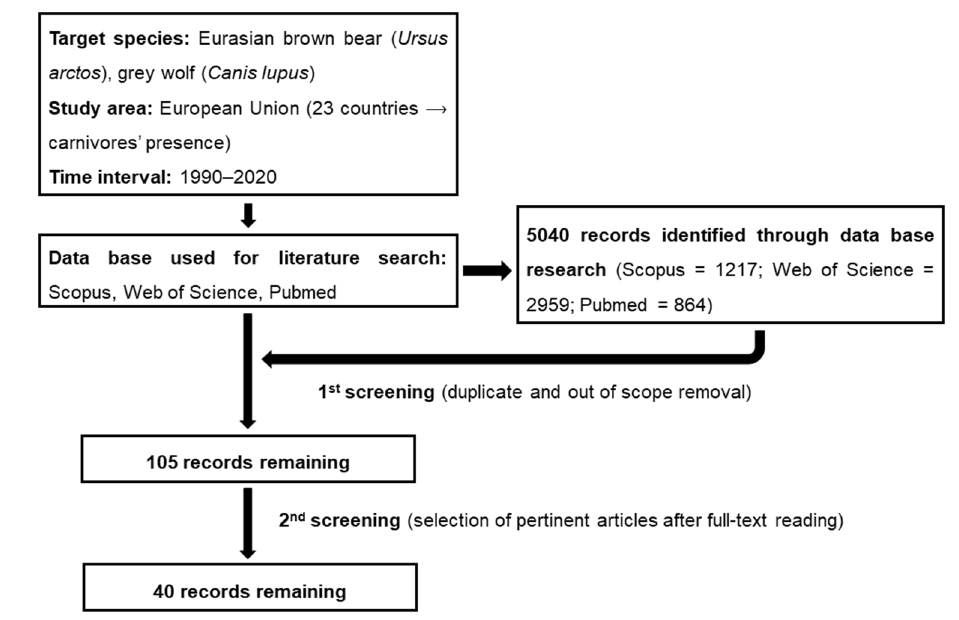
Figure 1. Overview of the criteria used for manuscript selection and dataset creation.